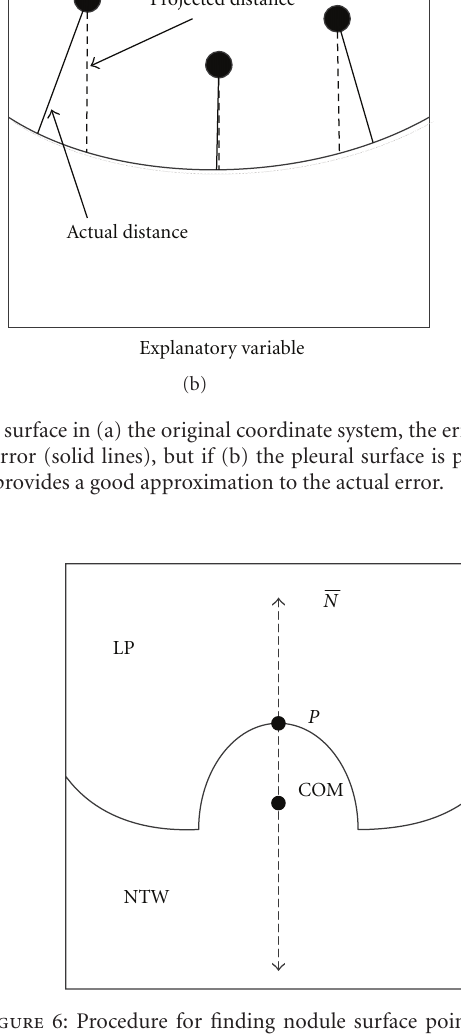
the surface function that has the least error compared to the actual surface.